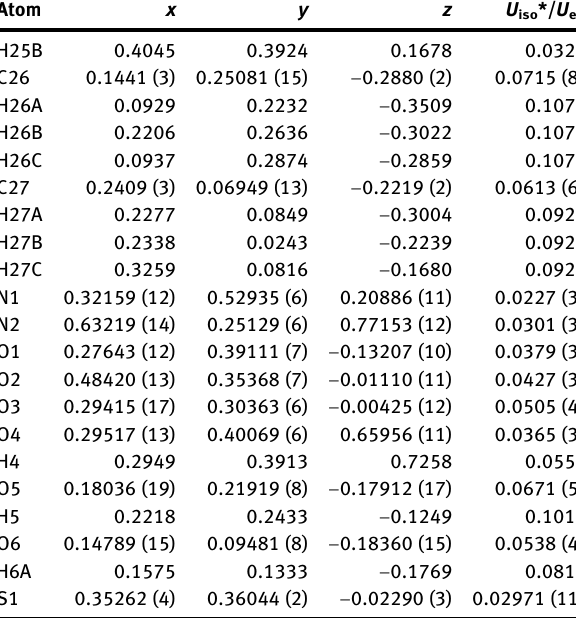
Table  : Fractional atomic coordinates and isotropic or equivalent isotropic displacement parameters (Å 